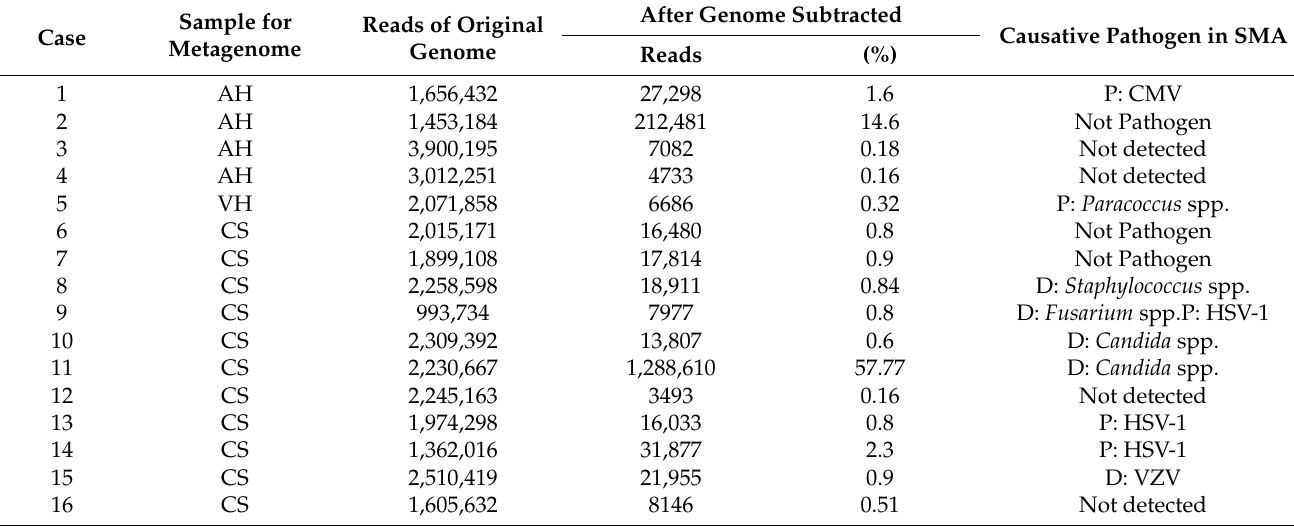
Table 2. Summary of SMA results in 16